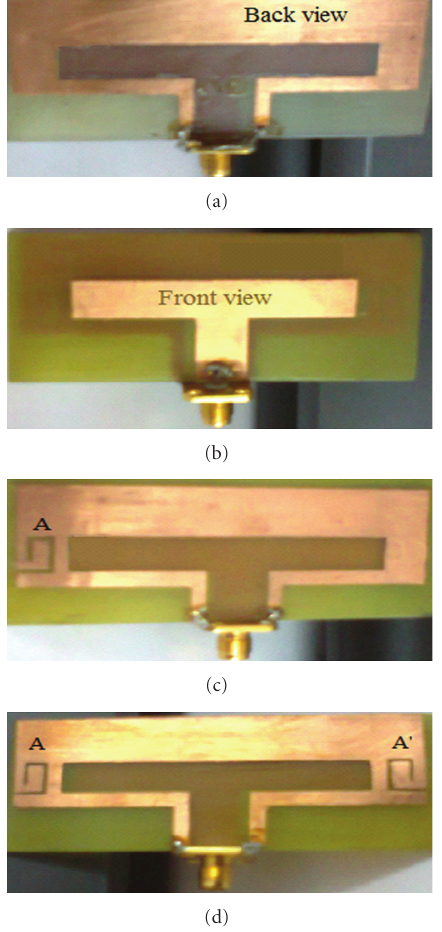
Figure 6: Photograph of the proposed antenna. (a) Back view without slot, (b) front view, (c) back view with slot (A), (d) back view with slot (A) and (A (cid:2)